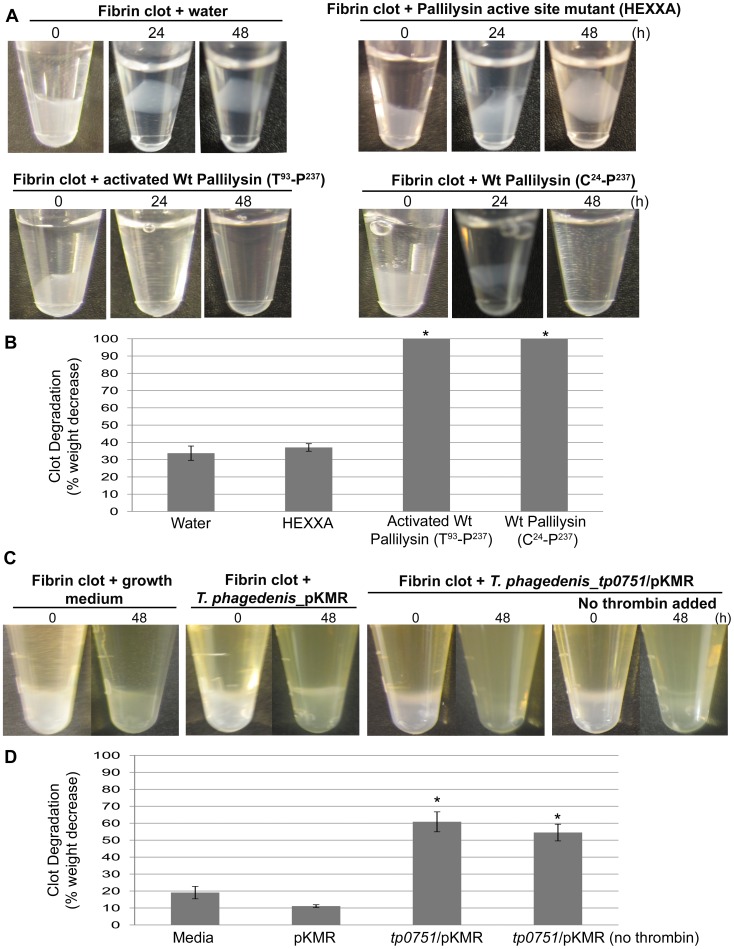
Pallilysin degrades fibrin clots.(A) Fibrin clots (generated from 300 µg fibrinogen) were incubated with water (negative control), pallilysin HEXXA (H202A) active site mutant (40 µg), autocatalytically activated wild-type pallilysin (T93-P237) (40 µg) or wild-type full-length pallilysin (C24-P237) (40 µg) for 48 h at 37°C in pallilysin activation buffer. After 0, 24, and 48 h, fibrin clot stability was analyzed visually. Results are representative of seven independent experiments. (B) Fibrin clot degradation by recombinant pallilysin was quantitated following 48 h incubation at 37°C. Clot weights were measured at 0 and 48 h post-incubation and percent clot degradation was determined. Mean readings from triplicate experiments are presented with bars indicating standard error (SE). Student's two-tailed t test indicated both forms of wild-type pallilysin exhibited statistically significant levels of fibrinolysis compared to the levels exhibited by water and HEXXA (* indicates p<0.0001). (C) Fibrin clots were incubated with TYGVS growth medium in the presence of thrombin (2 µg/ml), T. phagedenis transformed with the shuttle plasmid pKMR in the presence of thrombin (2 µg/ml), or T. phagedenis transformed with tp0751/pKMR in both the presence (2 µg/ml) and absence of thrombin. Treponemes were grown anaerobically for 48 h at 37°C, and the size of the fibrin clots was analyzed visually at 0 and 48 h. Results are representative of six independent experiments. The yellow coloration present in the tubes of Panel C is due to TYGVS growth medium. (D) Fibrin clot degradation by T. phagedenis transformed with tp0751/pKMR in both the presence (2 µg/ml) and absence of thrombin was quantitated following 48 h growth at 37°C as described in (B). Student's two-tailed t test indicated that T. phagedenis transformed with tp0751/pKMR exhibited statistically significant levels of fibrinolysis compared to the levels exhibited by T. phagedenis transformed with pKMR alone (* indicates p<0.005).